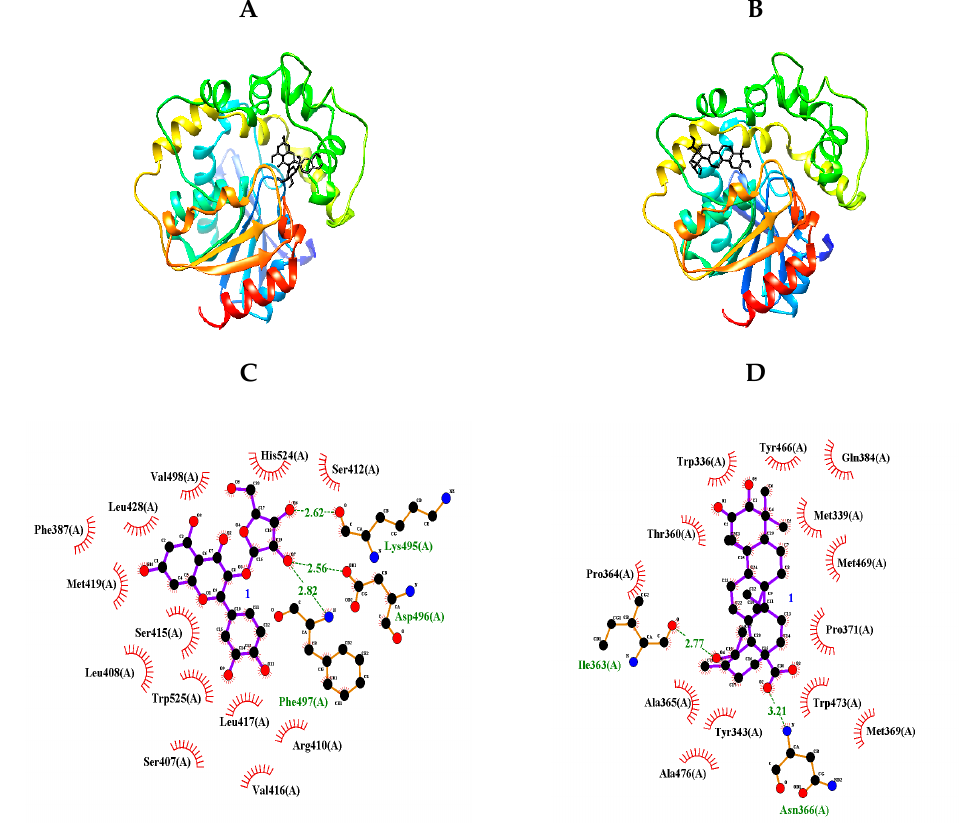
Figure 3. Predicted docking poses between compounds 1 and 4 and sEH ( A , B ). Hydrogen bonds of inhibitors 1 and 4 of the catalytic site, respectively ( C , D ).